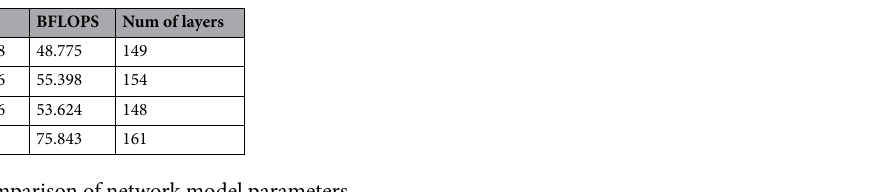
Table 2. Comparison of network model